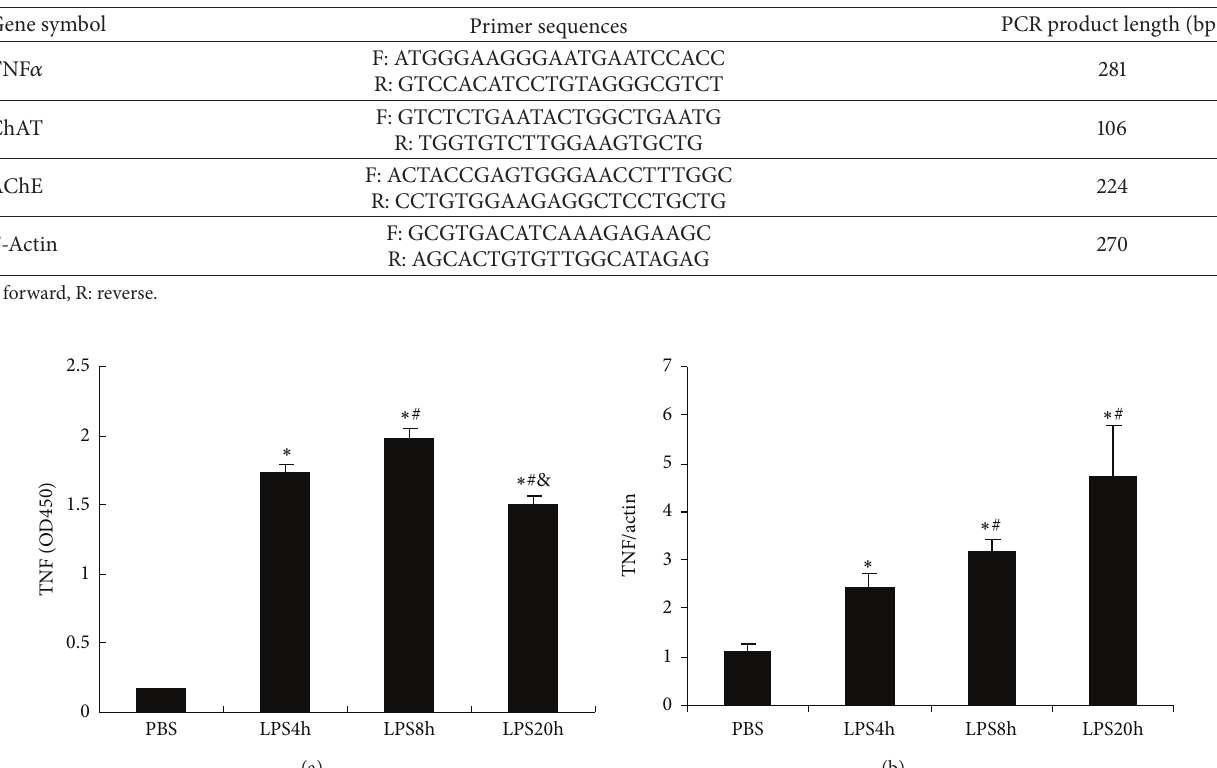
Table 1: Sequences of primers used for real-time quantitative PCR analysis.